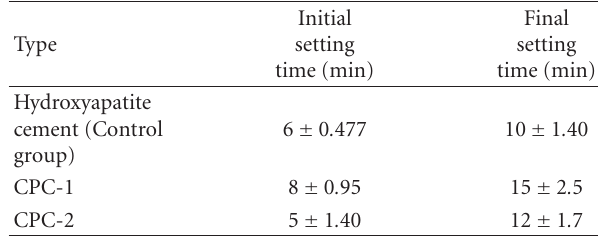
Table 2: The Initial (I) and Final (F) setting times (inmin) of hydroxyapatite cement and the two polymeric calcium phosphate cements (CPCs) (values are means ± SD ; n =